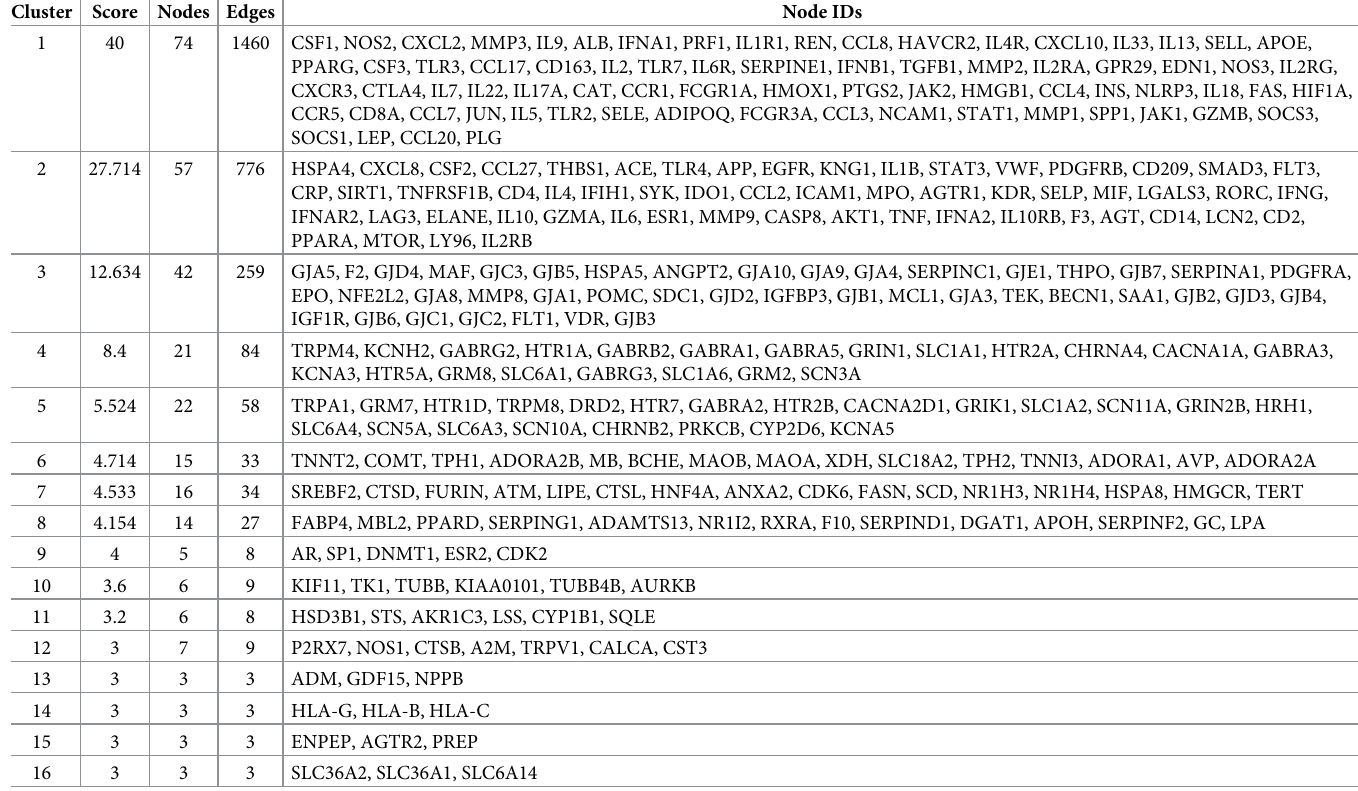
using the MCODE plug-in. 16 clusters were revealed from the STRING network (Table 2). After cluster generation, top hub genes were detected, showing highly interconnected regions. Hence, they were considered the significant nodes done by the cytoHubba plug-in in Cytoscape. TNF, IL6, IL10, IL1B, IL4, IFNG, IL17A, CSF2, CD4 and CXCL8 were the top 10 hub genes. These genes were ranked by the MCC method. MCC method is the most effective Table 2. MCODE result shows 16 clusters score, number of nodes and edges, and node IDs. Cluster Score Nodes